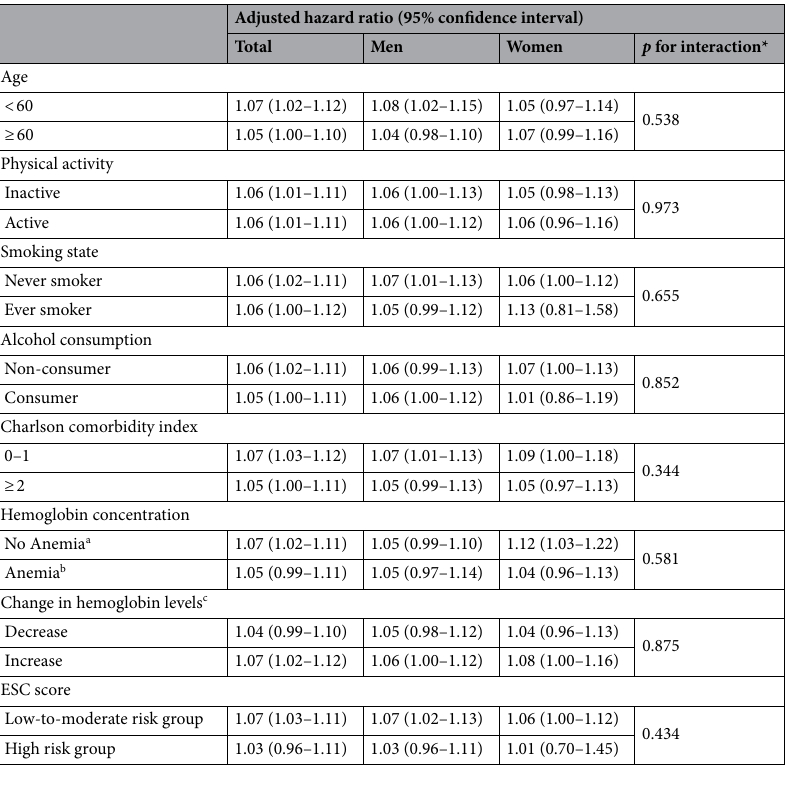
Table 3. Stratified analyses on the association of hemoglobin variability with cardiovascular disease risk according to subgroups of age, initial hemoglobin level, change in hemoglobin levels, smoking state, physical activity, alcohol consumption, Charlson comorbidity index and ESC SCORE. Hazard ratio calculated by Cox proportional hazards regression analysis after adjustments for age, sex, initial hemoglobin level, change in hemoglobin level, household income, smoking, alcohol consumption, physical activity, systolic blood pressure, fasting serum glucose, total cholesterol, and Charlson comorbidity index. * p value for interaction between subgroups in total cohort. a No anemia in all three health examinations. b Anemia at least once among three health examinations. c The direction of change between the hemoglobin concentration in first health examination with that in third health examination of each